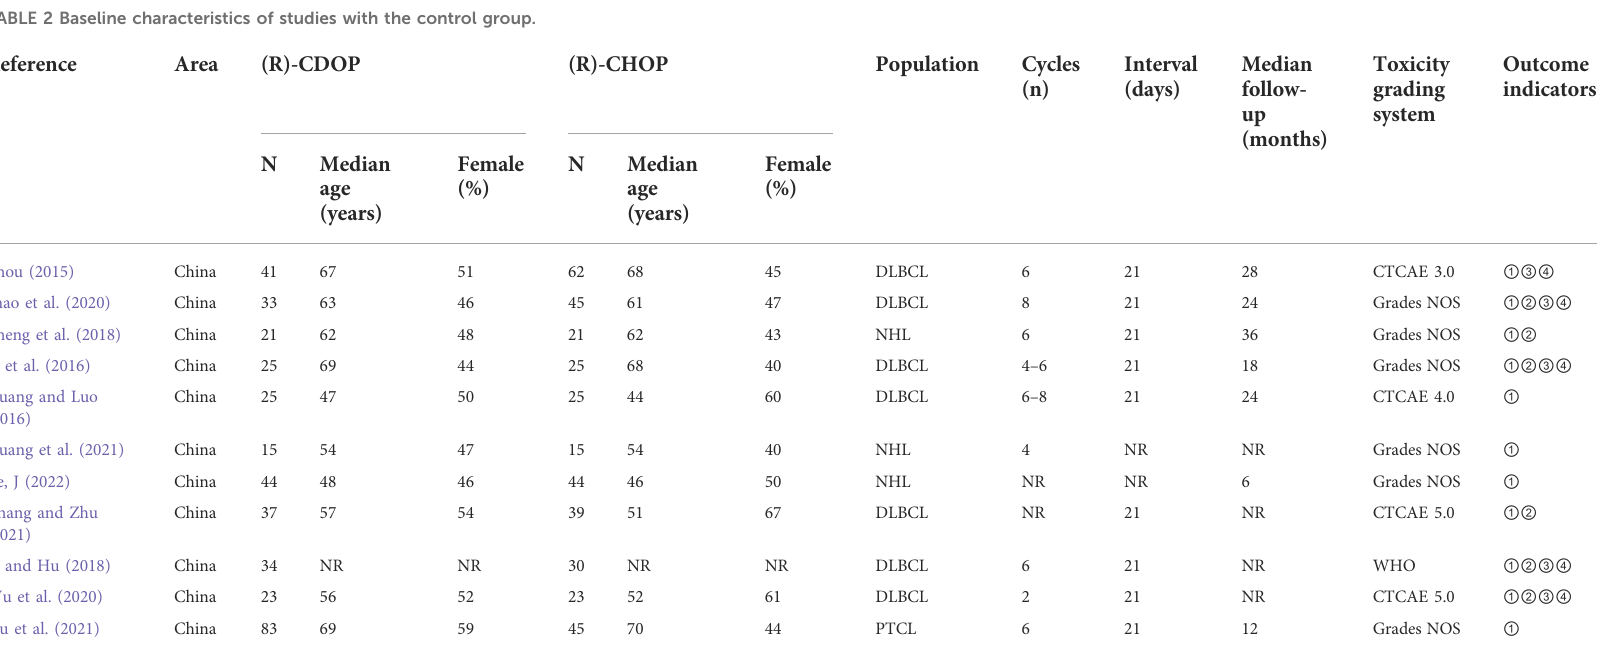
TABLE 2 Baseline characteristics of studies with the control